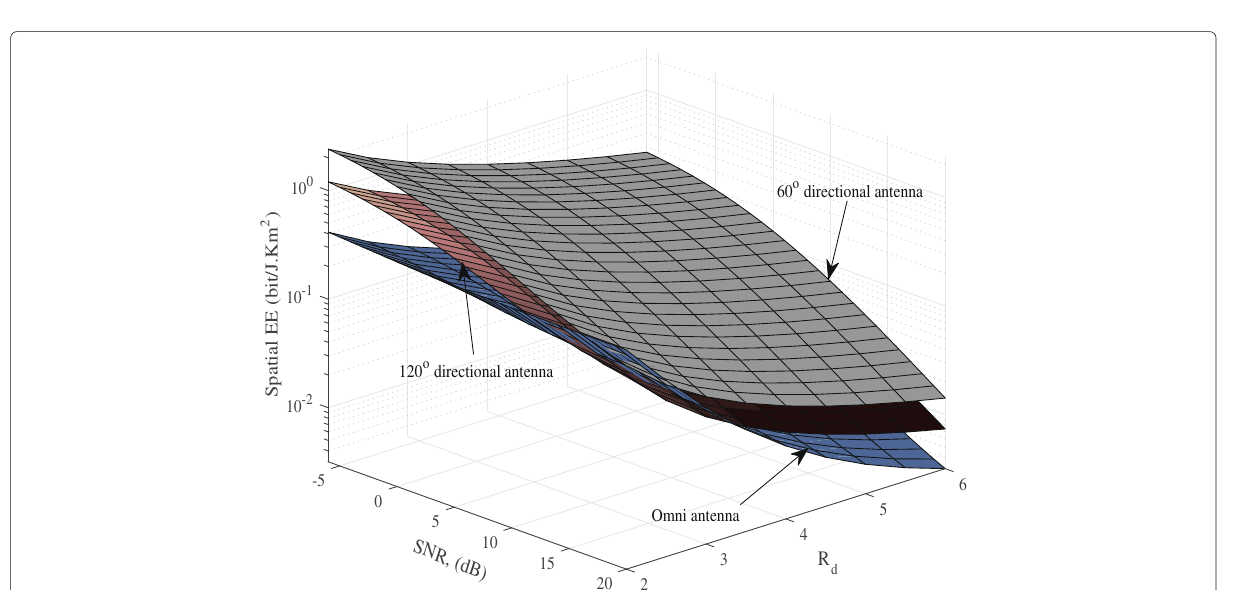
Fig. 12 Spatial energy efficiency in (bit/J km 2 ) of multi-cell cellular network as a function of SNR and normalized reuse distance, R d for omni, 120 ◦ and 60 ◦ antenna configurations with m = 4 and α = 4. Spatial EE for omni antenna system, spatial EE for 120 ◦ sectorized antenna system, and spatial EE for 60 ◦ sectorized antenna